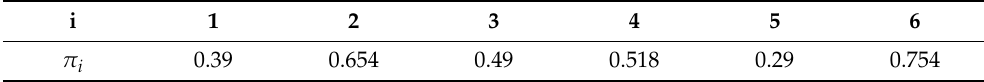
Table 2. Computing π i